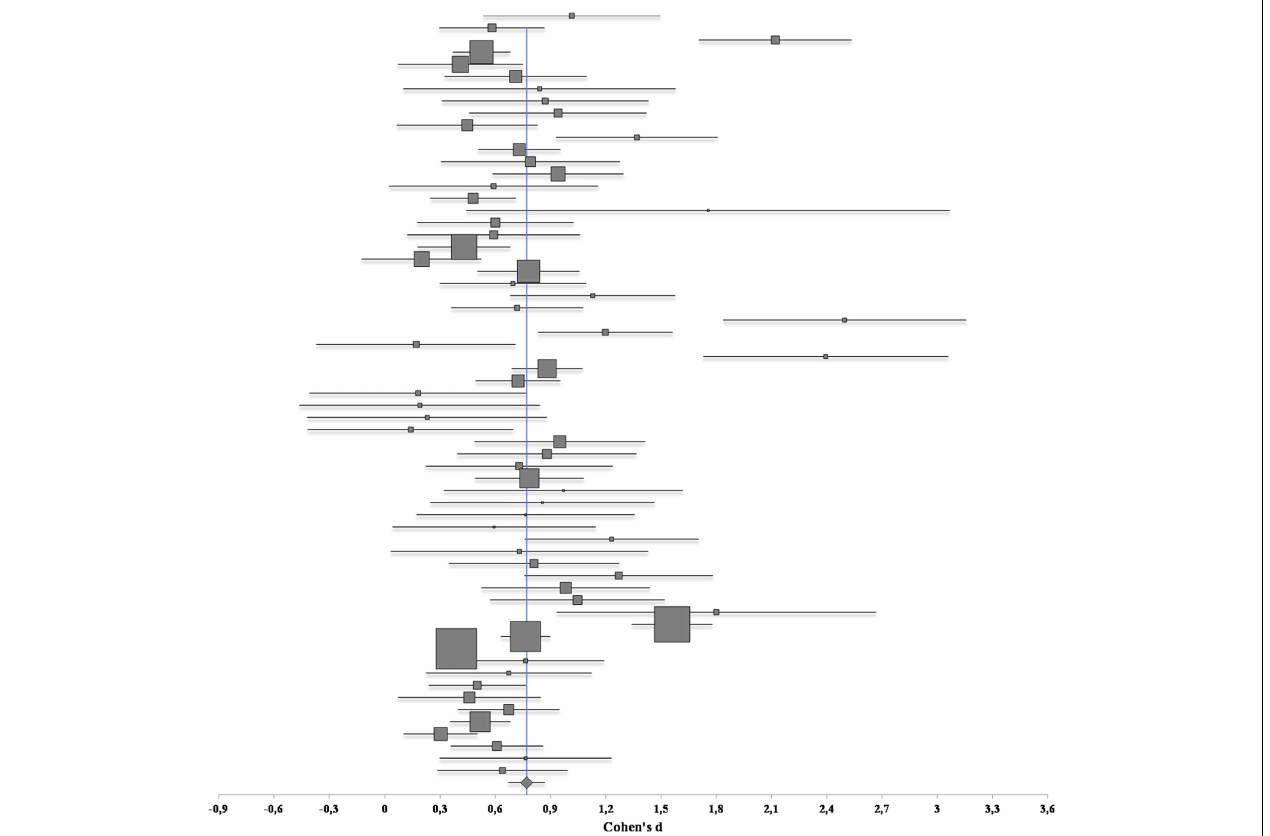
FIGURE 1 | Forest plot of effect sizes from included studies incorporating 95% CI. Note: The presentation of studies follows the alphabetic order displayed in Table 1 .